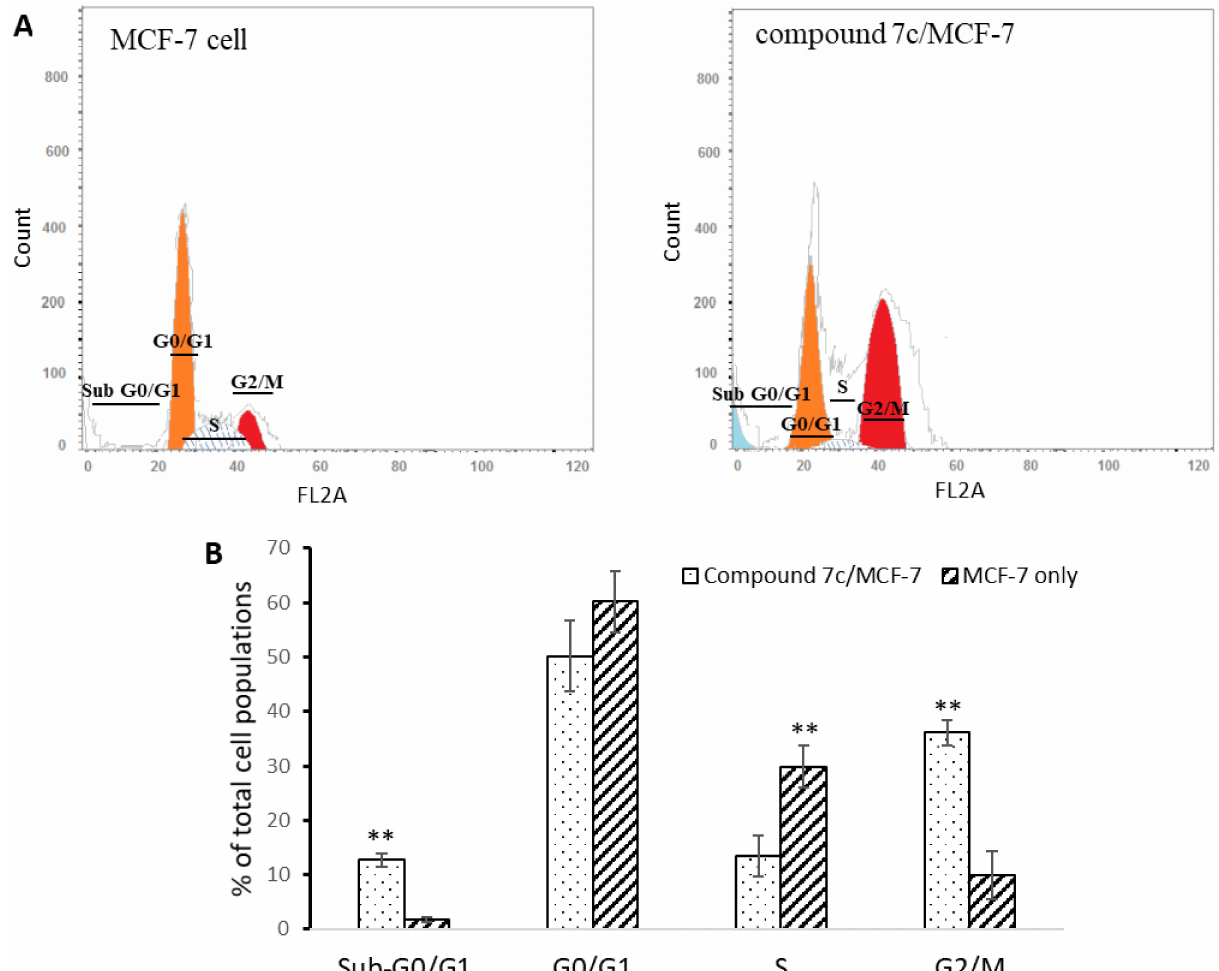
Figure 1. The effect of compound 7c at the concentration of 1.73 µ M on the MCF-7 cell-cycle phases. ( A ) Representative flow cytometry data of the cell-cycle phases. ( B ) Percentage of the total cell populations at each cell-cycle phase. ** p < 0.01 according to Tukey test.